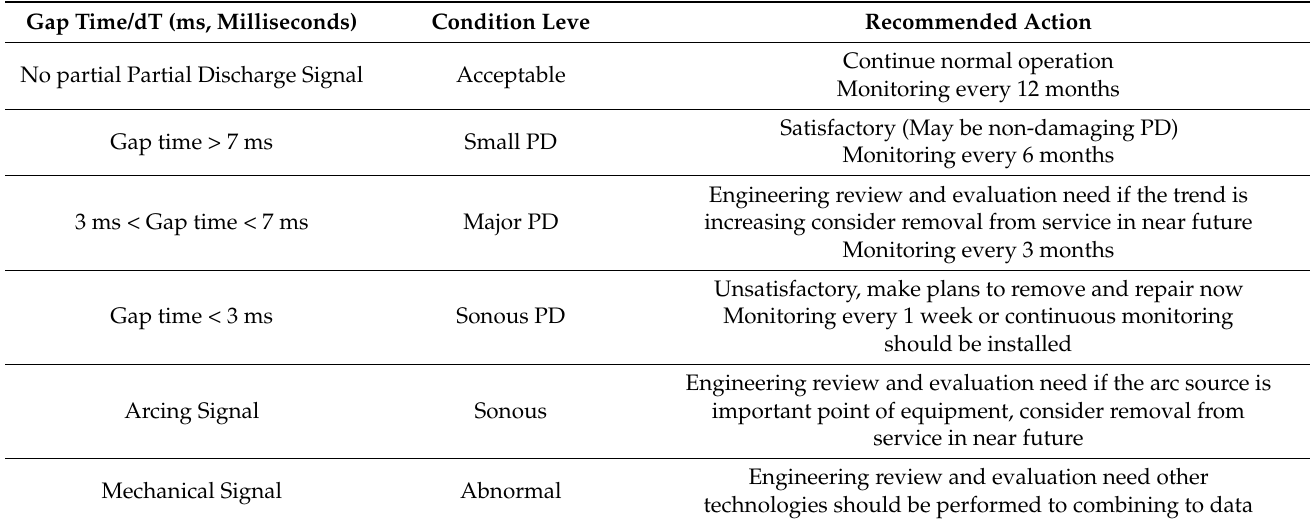
Table 1. The risk level of PD according to the PowerPD reference.